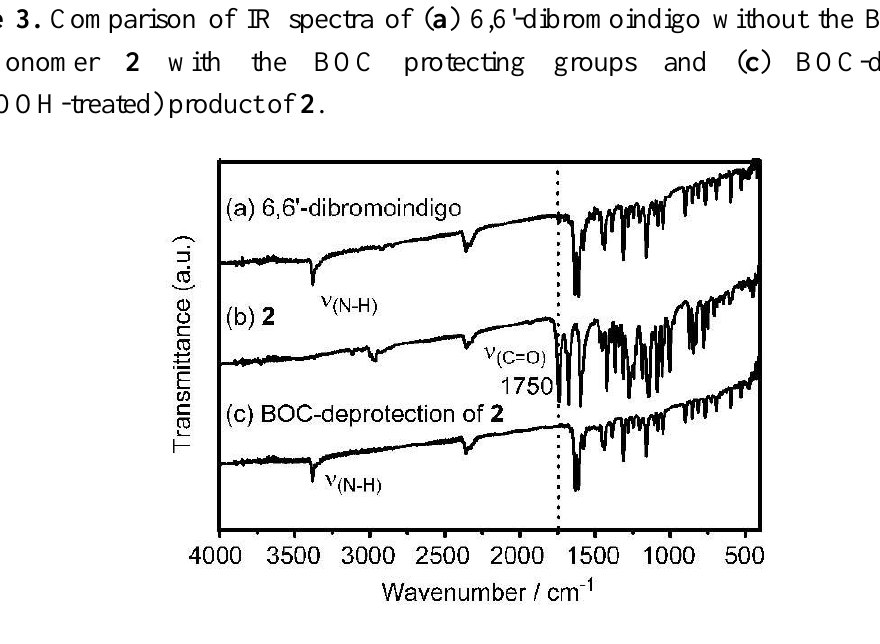
Figure 2. IR spectra of ( a ) P(BOCI-Flu) and ( b ) its deprotected (CF product. The absorption peak at approximately 2300 cm −1 is due to CO